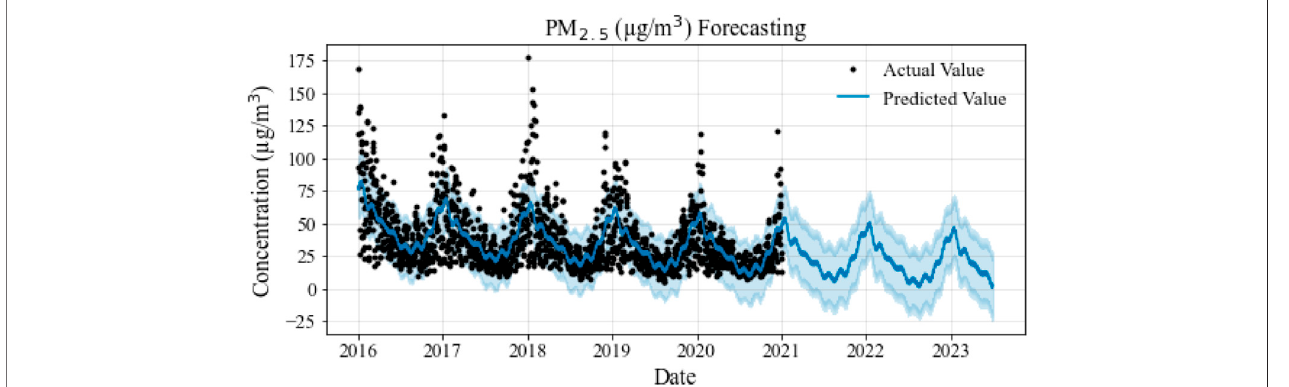
FIGURE 4 | PM 2.5 (µg/m 3 ) forecasting in jiangsu